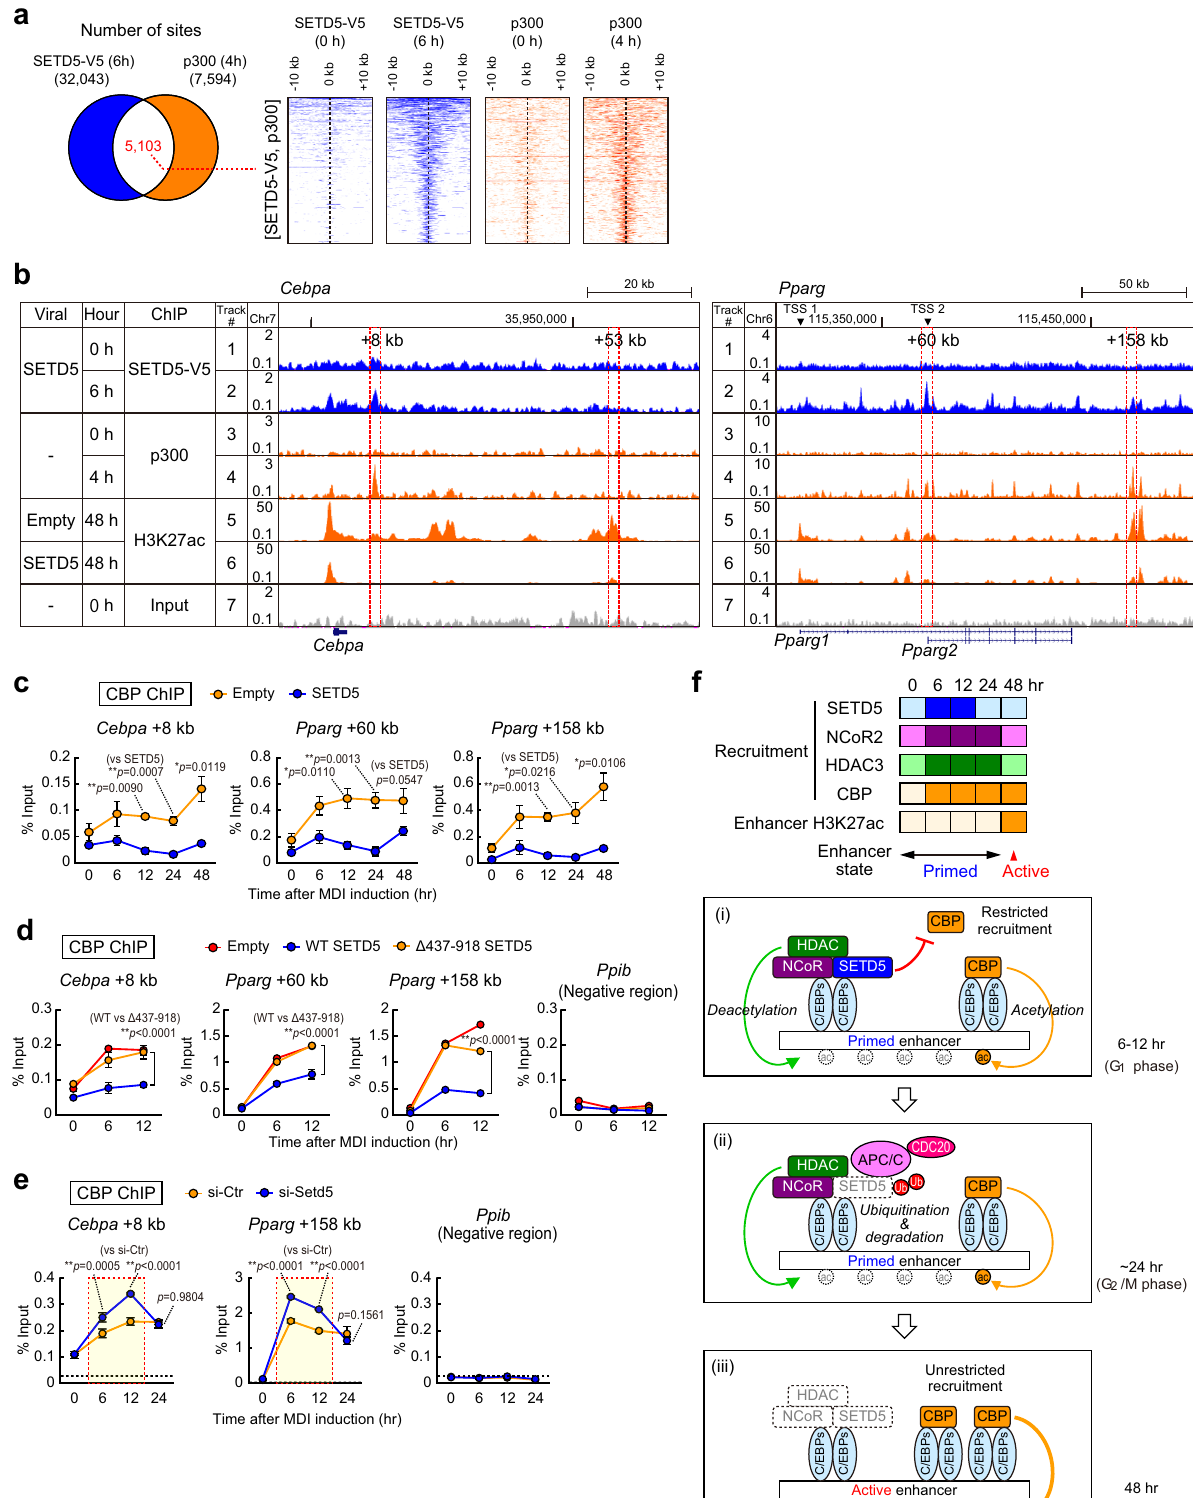
Collection (Manassas, VA, USA). Plat-E cell line was purchased from Cosmo Bio Co Ltd. 3T3-L1, HEK293, and Plat-E cells were maintained in Dulbecco ’ s modi fi